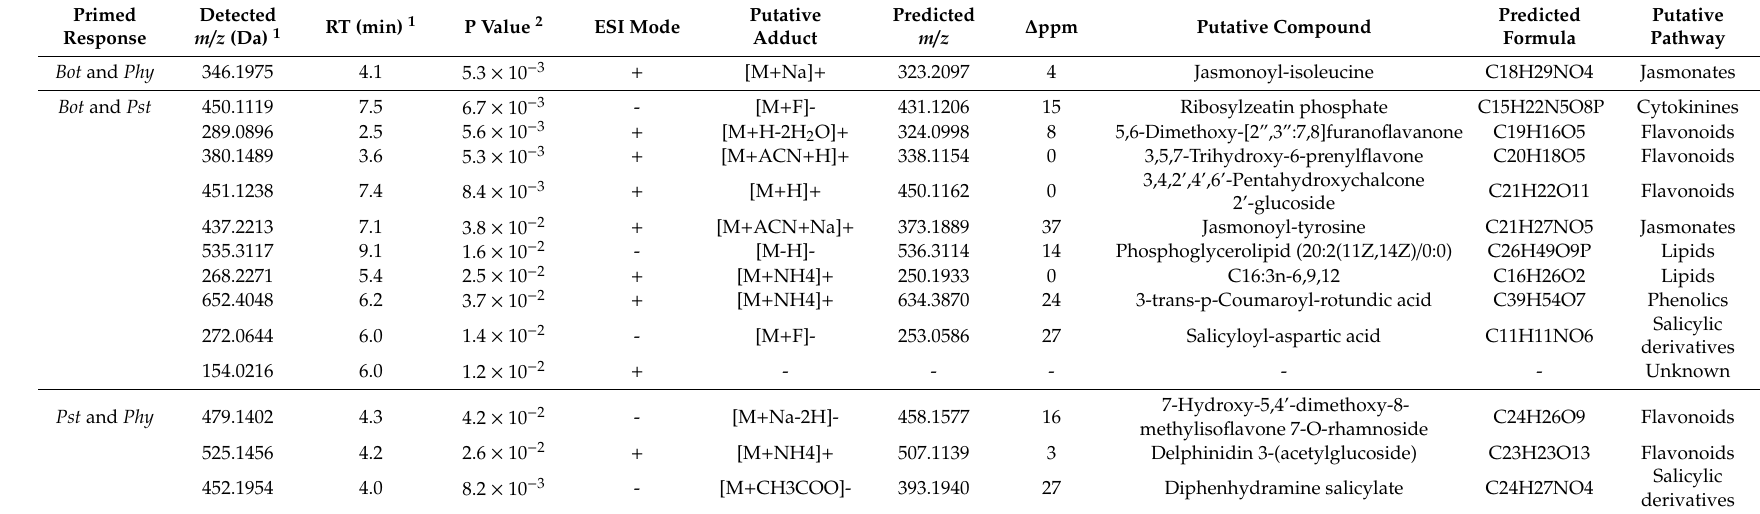
Table 3. Putative annotation of the primed response